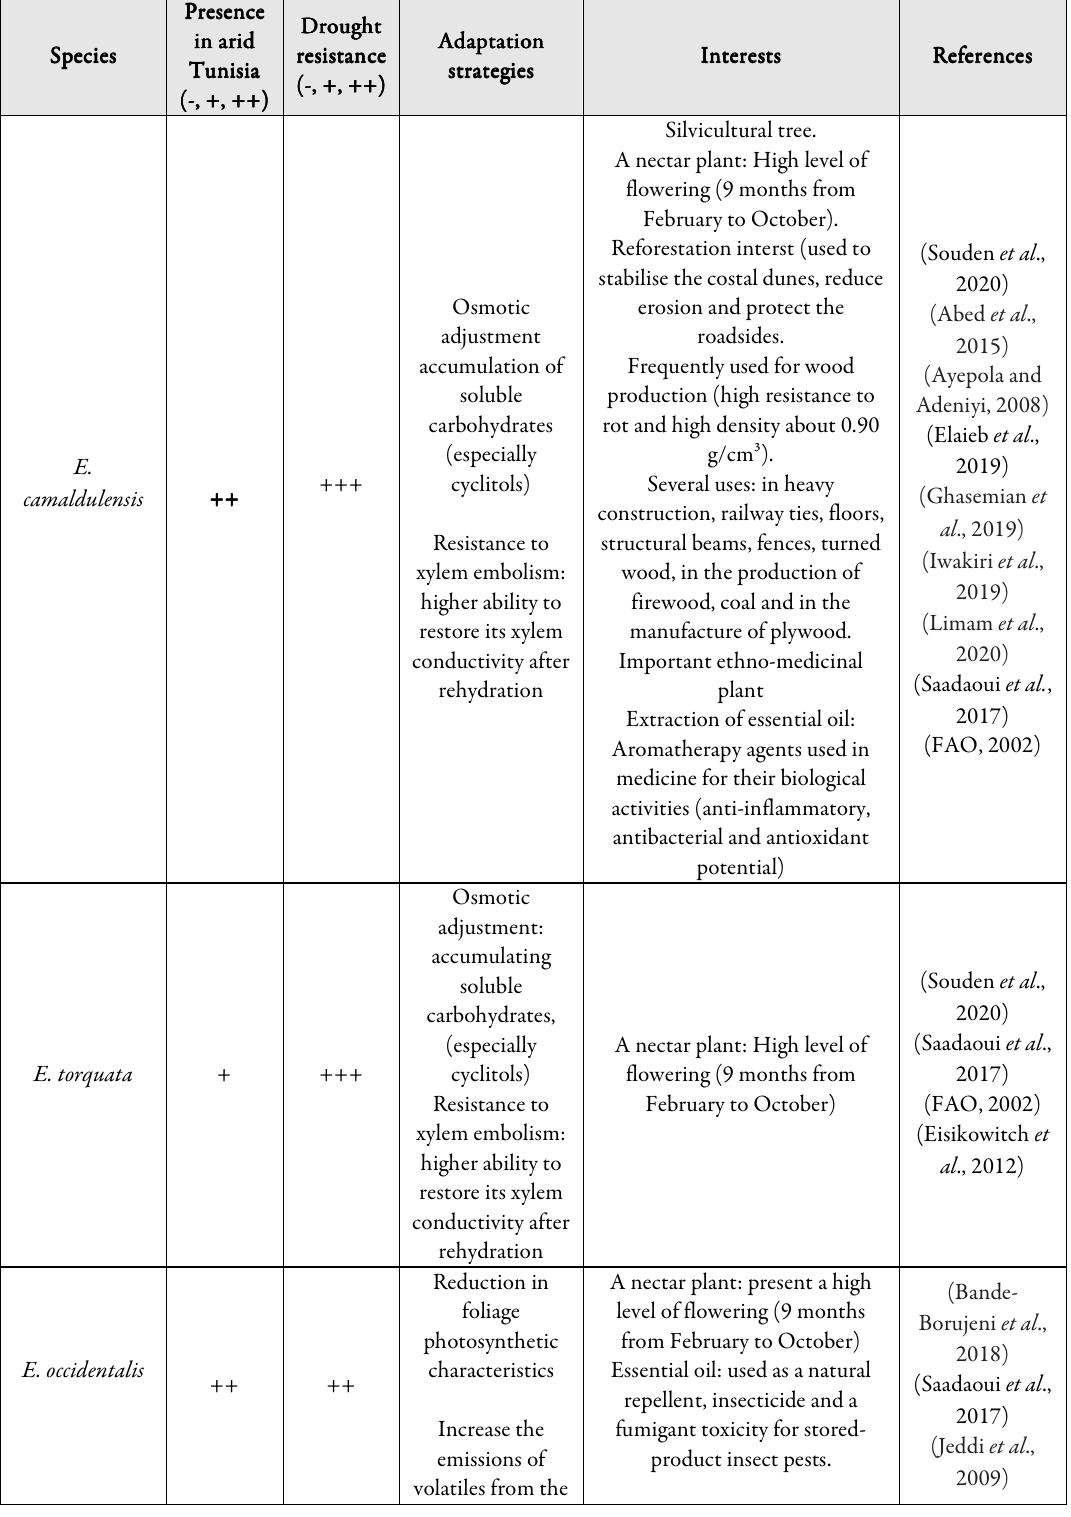
Table Table Table Table 1.1.1.1. Comparison between eucalyptus species presents in the Tunisian arid region